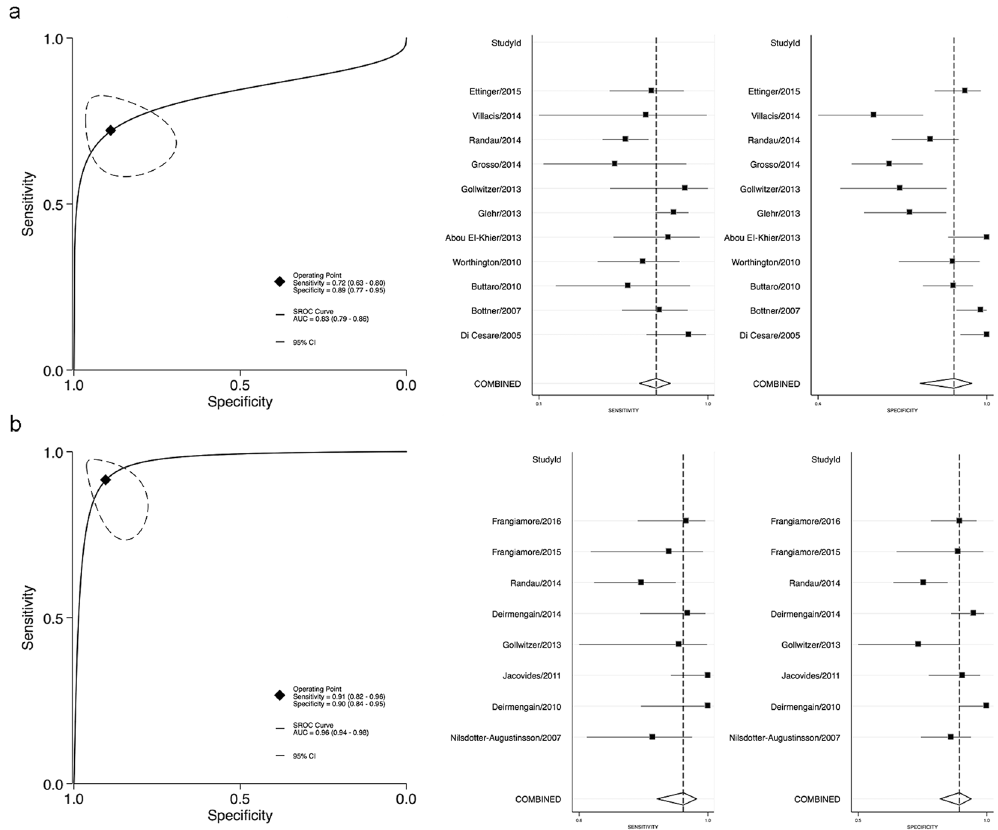
Figure 2. Summary receiver-operating characteristic curves and forest plots for serum ( a ) and synovial fluid interleukin (IL)-6 ( b